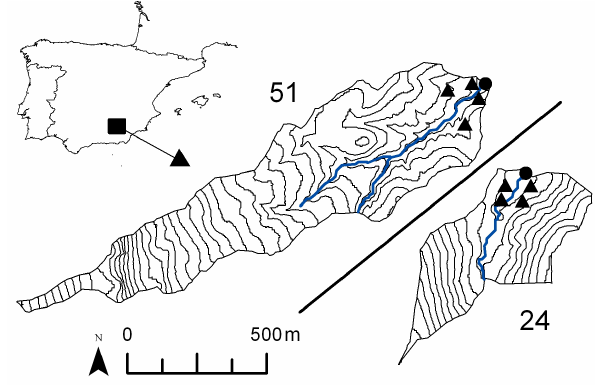
Fig. 1. General location and details of the two subcatchments (C51 and C24), the check-dam (black circle) and of the soil pits (black